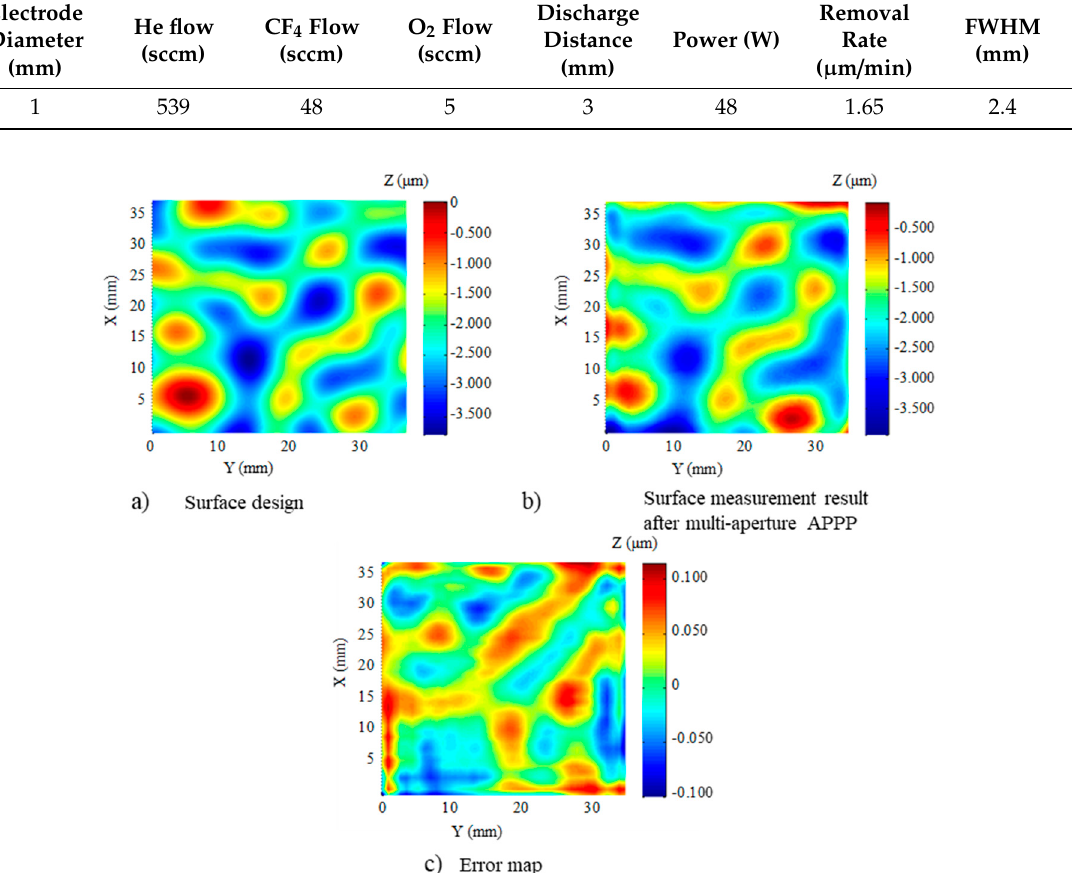
Table 6. Process parameters for removal function 2 (cid:79) .